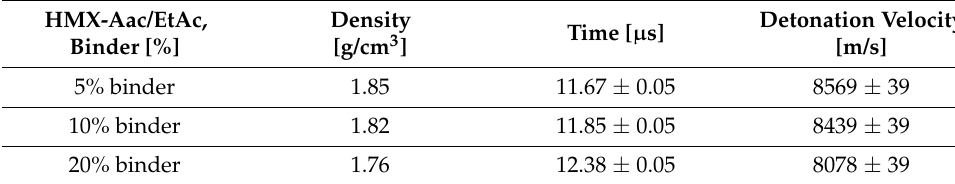
Table 7. Detonation velocities.